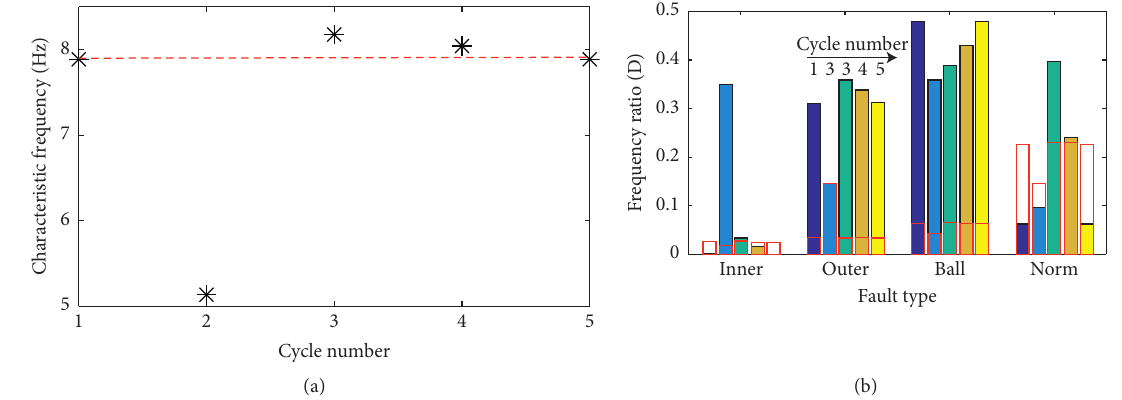
Figure 10: Automatic fault identification. (a) Characteristic frequency in each cycle. (b) The frequency ratio of fault types in each